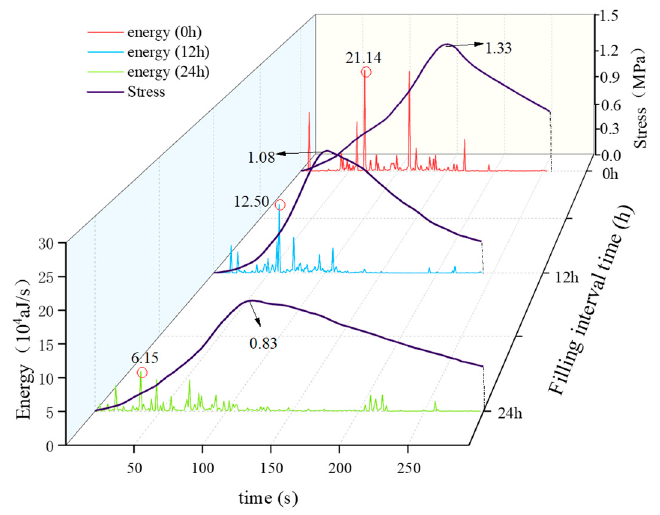
Figure 7. The energy of LCTB with different filling interval time.